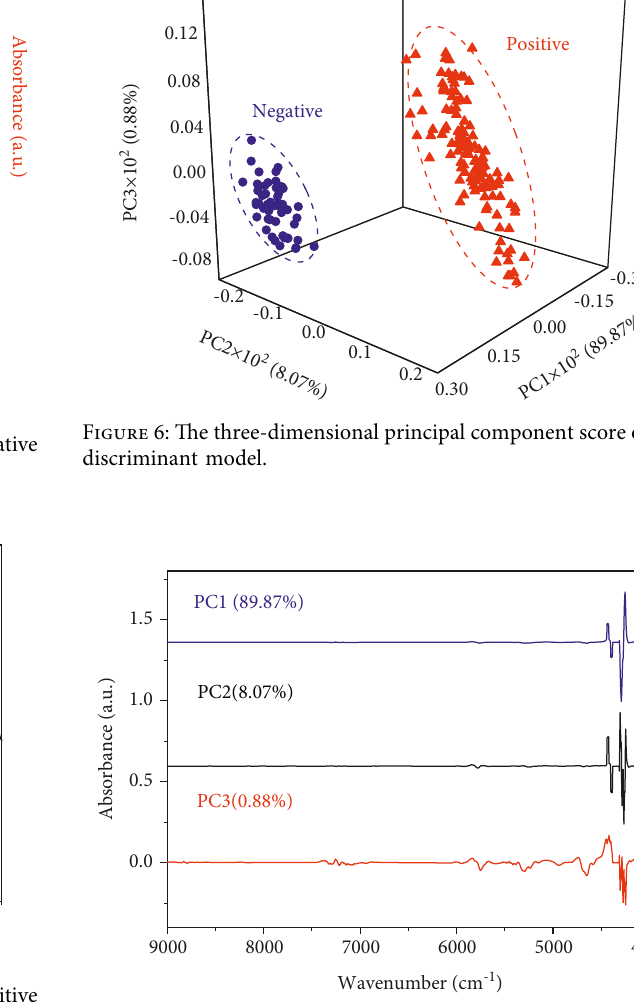
Figure 7: Principal component spectroscopic analysis of